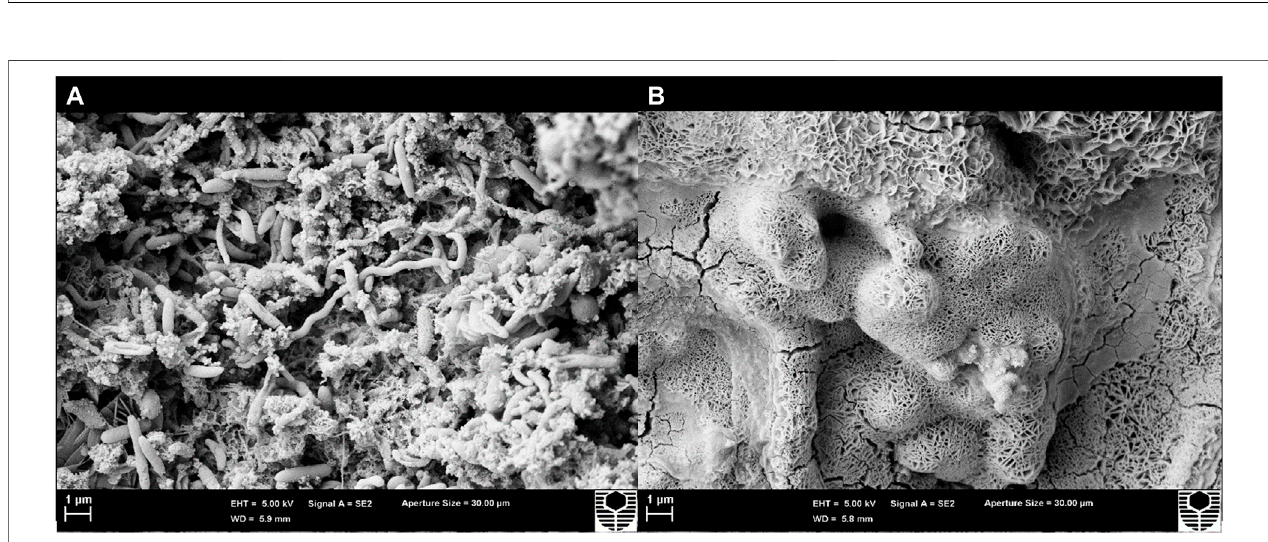
FIGURE 5 | Scanning electron micrographs of a coupon surface captured before (A) and after 4 h exposure to CTA-4OHcinn (B) . Surface A shows structures resembling bacterial cells not observed on surface B.